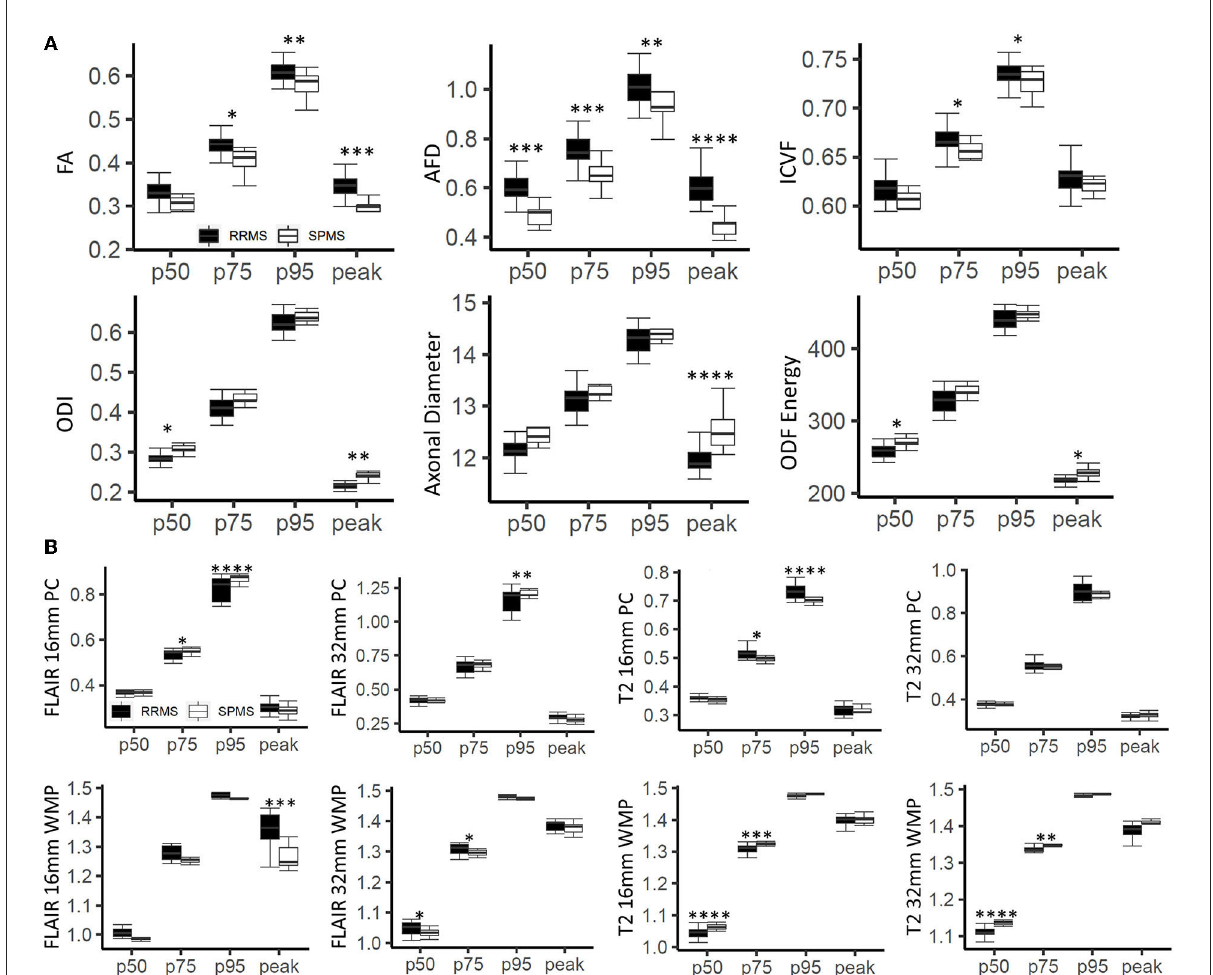
FIGURE4 Histogram-based outcomes by cohort. (A) Demonstrates results for diffusion measures, and (B) for texture measures from phase congruency. The stars indicate post-hoc significance: * p < 0.05, ** p < 0.01, *** p < 0.001, **** p < 0.0001. The boxes plot the median, interquartile range (IQR), and